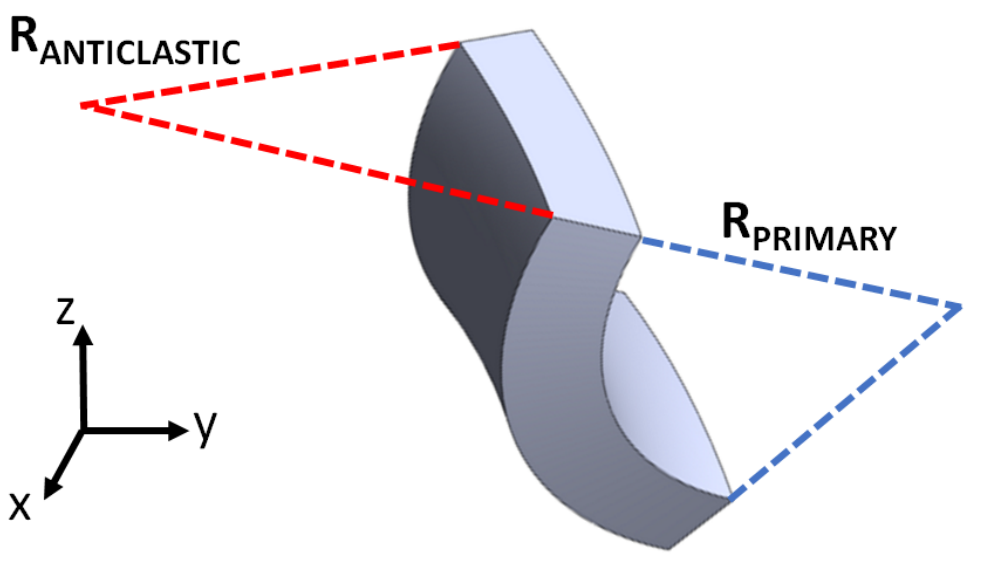
Figure 8. sketch of anticlastic bending